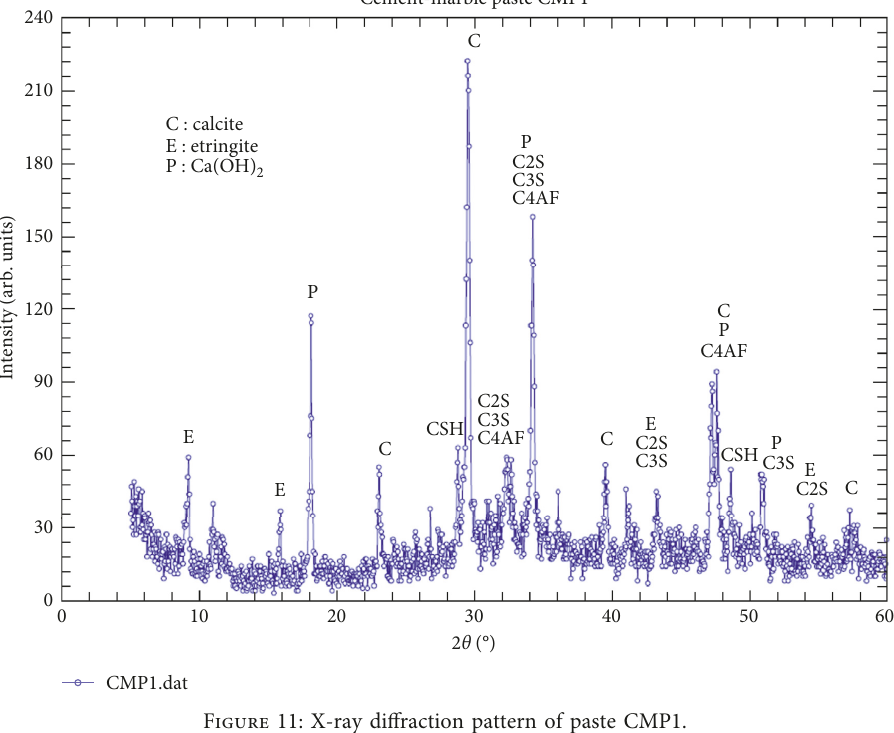
Figure 11: X-ray diffraction pattern of paste CMP1.